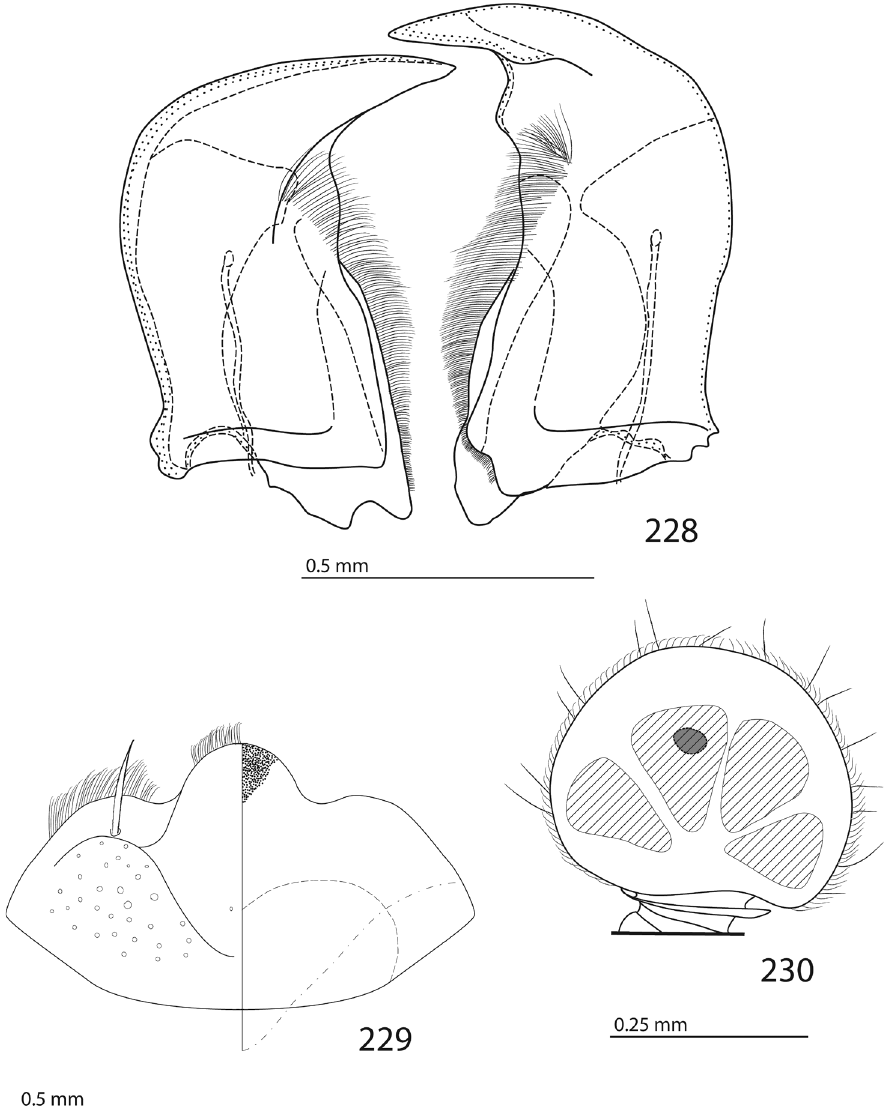
Body (Fig. 219) rectangular oval, convex; cuticle shining; pronotum dark brown with bronze metallic luster, elytra with blue metallic luster; legs, mouthparts and an- tennae castaneous brown; antennal club